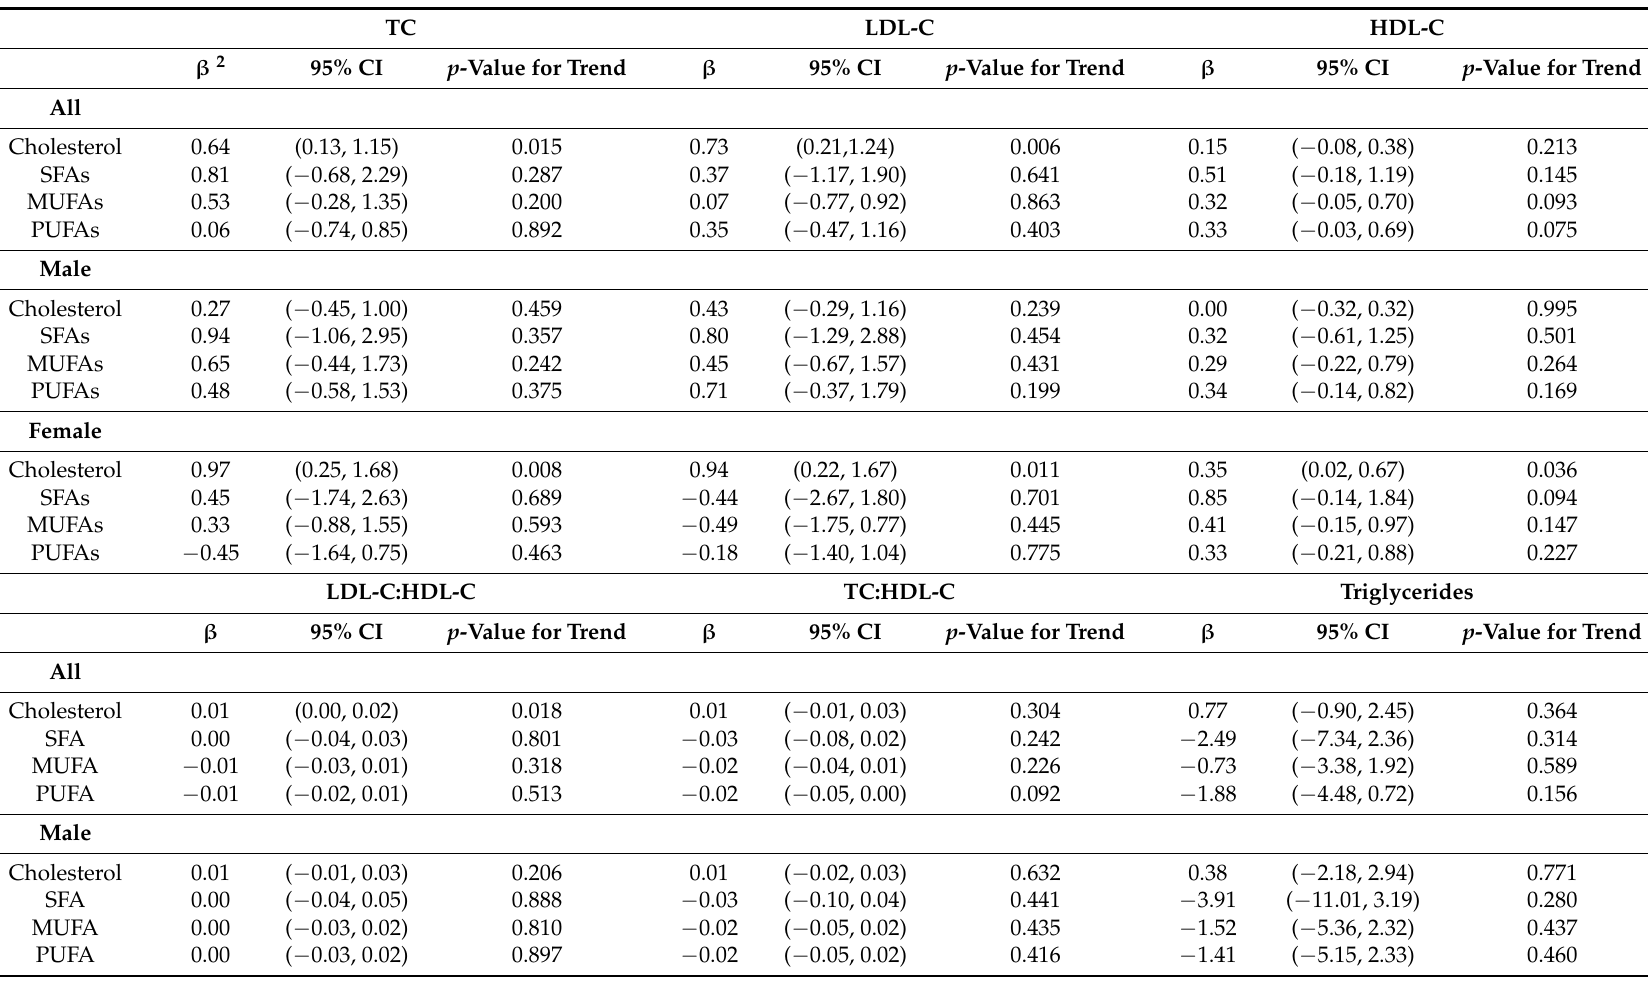
Table 2. General linear regression between dietary cholesterol and fatty acids intake and serum cholesterol and triglycerides level in SDHS 2012–2013 1